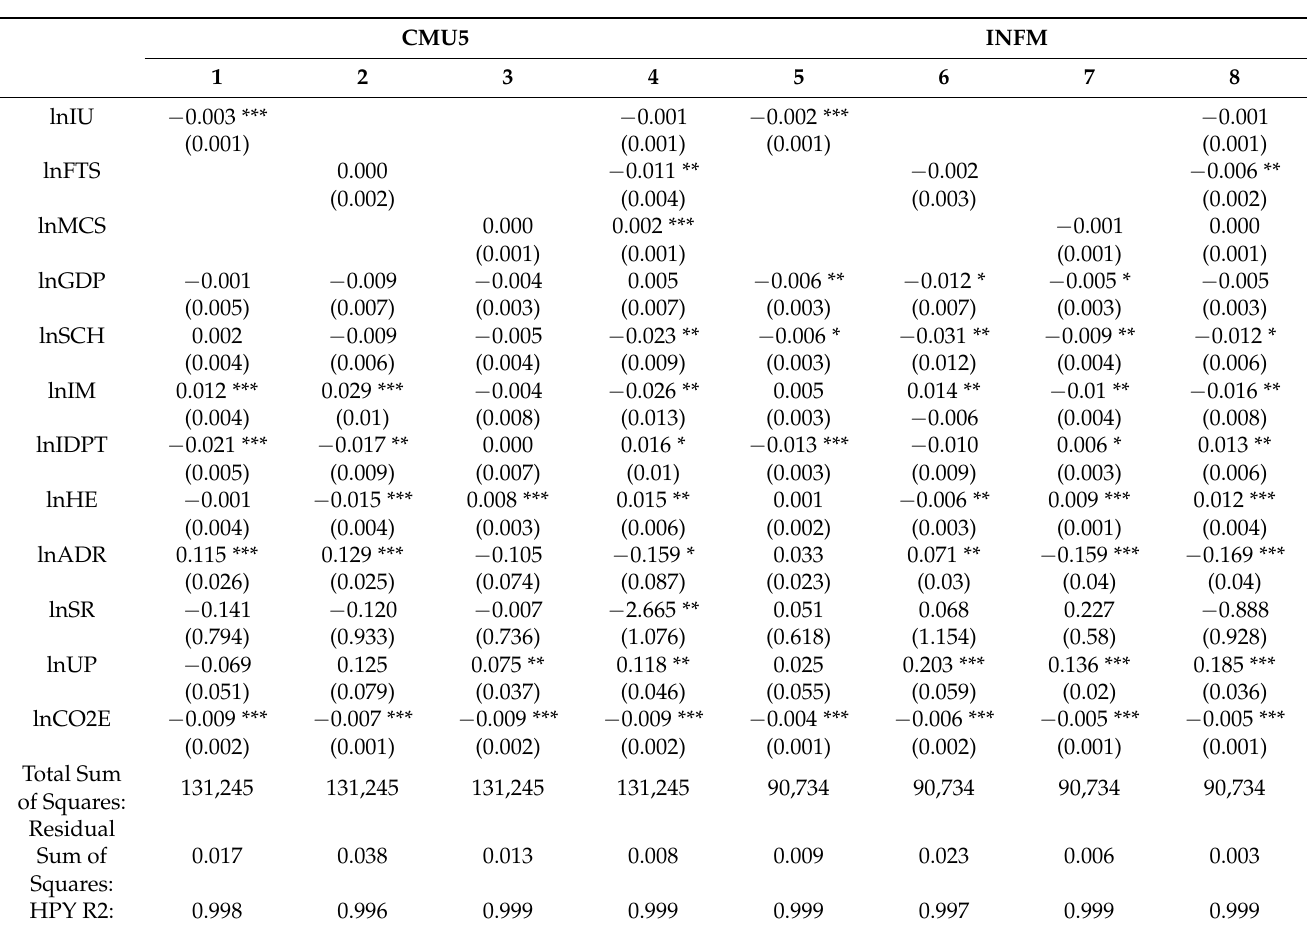
Table 5. PCCE using Driscoll–Kraay robust error estimation results for infant mortality and child mortality under